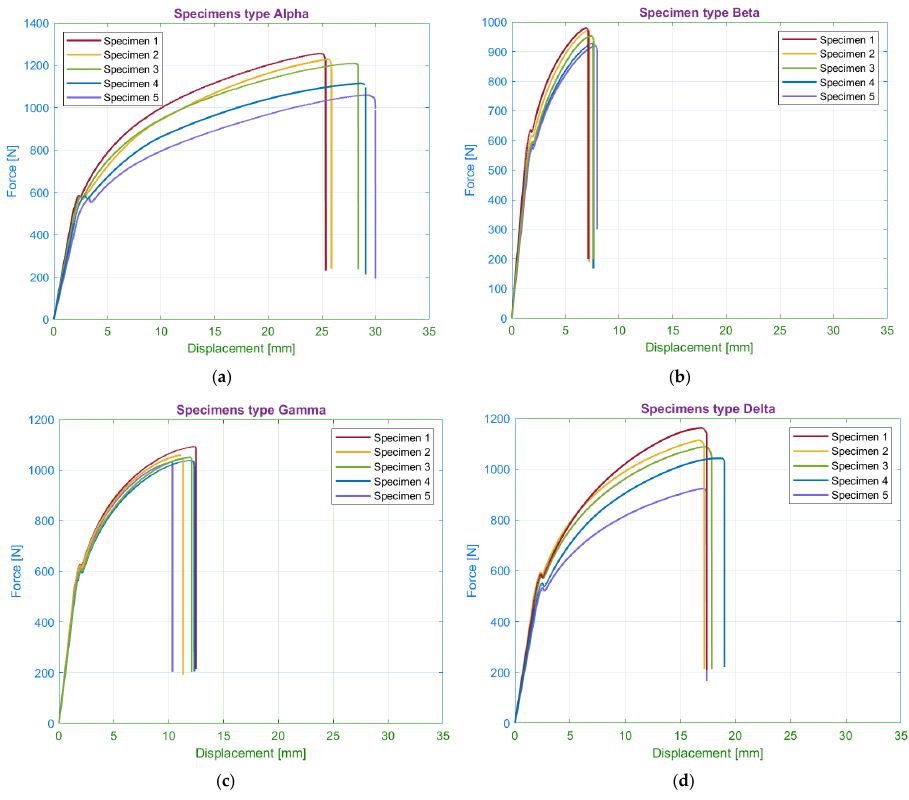
Figure 9 . Tensile diagrams for specimens with infill orientation: ( a ) 45/ − 45; ( b ) 0/90; ( c ) 15/ − 75; ( d ) 30/ − 60.